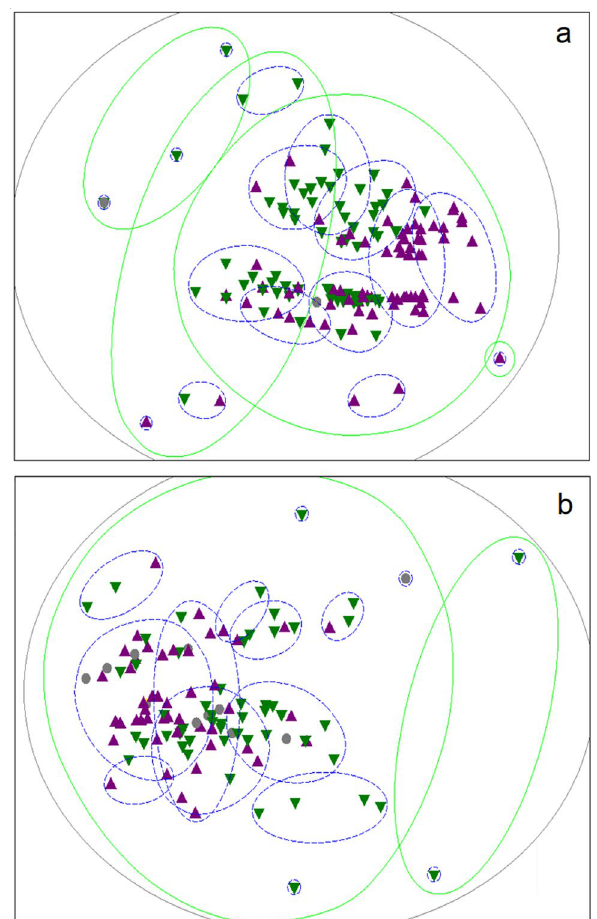
Figure 2. The Bray–Curtis similarity matrices which compared how similar individuals were in their behaviour (aggressive, submissive, exploratory) were visualised for both the Caribbean ( a ) (2D stress = 0.14) and Chilean ( b ) (2D stress = 0.15) using non-metric multidimensional scaling (NMDS) using PRIMER 6 68 . This plotted each bird’s score in a 2D space and grouped them according to similarity. Birds which expressed similar behavioural patterns are located closer to each other on the graph. Hierarchical cluster analysis was applied to generate percentage threshold of similarity. All the Caribbean birds were at least 34% similar in their behaviour, while all the Chilean birds were at least 29% similar in their behaviour (represented by the outermost grey circle in each panel respectively). The 50% (green, solid circles) and 80% (blue, dashed circles) similarity thresholds are displayed to better identify sub-groups of birds which display increasingly similar behavioural patterns. Male (purple, ▲ ), female (green, ▼ ) and birds of unknown sex (grey, ● ) are distinguishable by colour and/or shape.